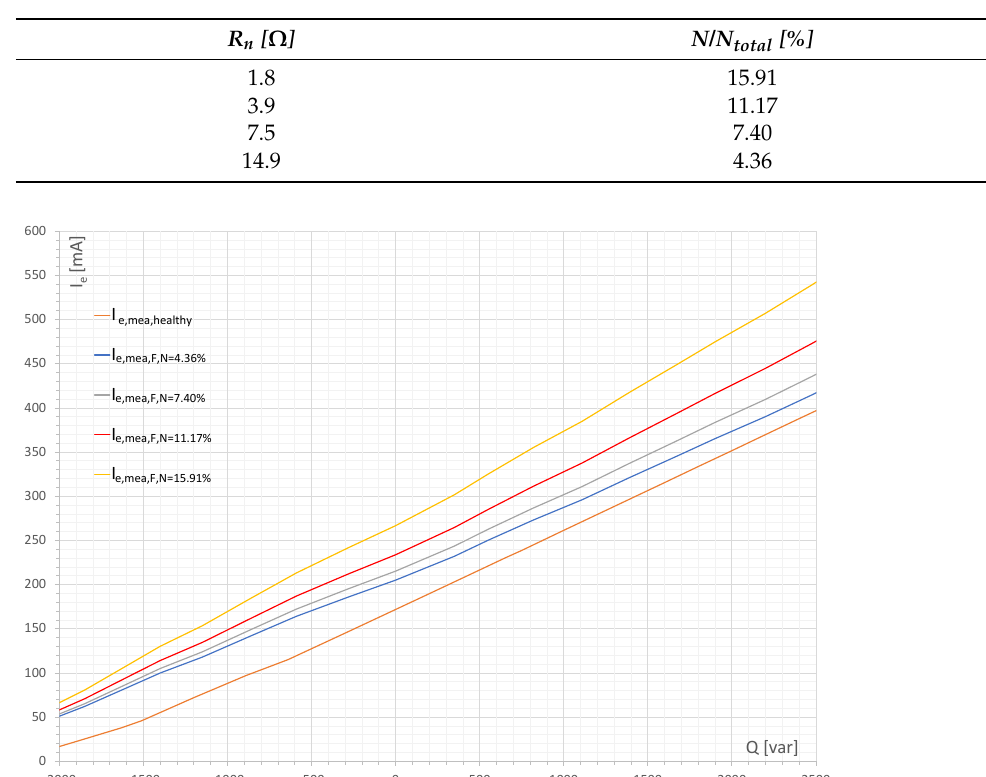
Table 5. Relationships between the parallel resistor value ( R n ) and the equivalent proportion of shorted turns ( N ) with respect to the whole field winding ( N total ). The whole field winding constitutes a 12.6 Ω total impedance.